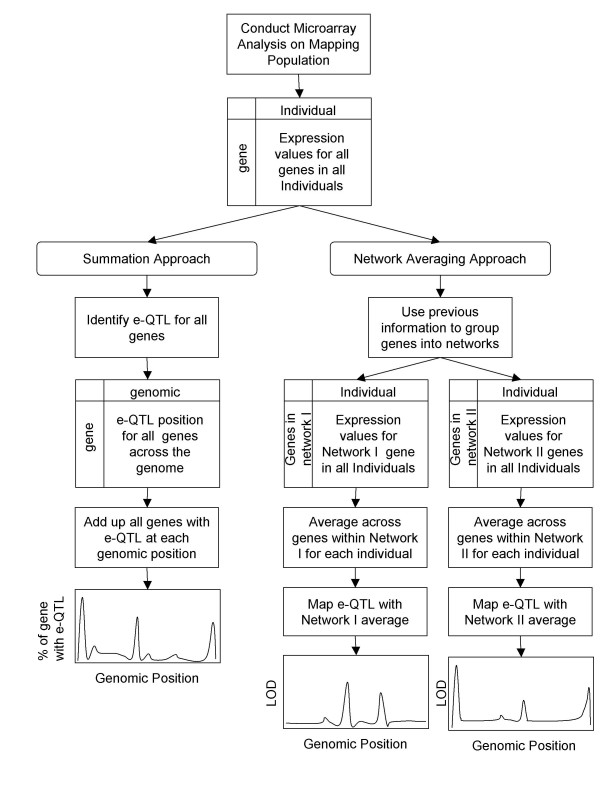
Network analysis of microarray data. A flow-chart describing the summation approach and the network averaging approach. The summation approach is previously described in the literature (see references in the text). The network averaging approach is the method developed and utilized in this study.